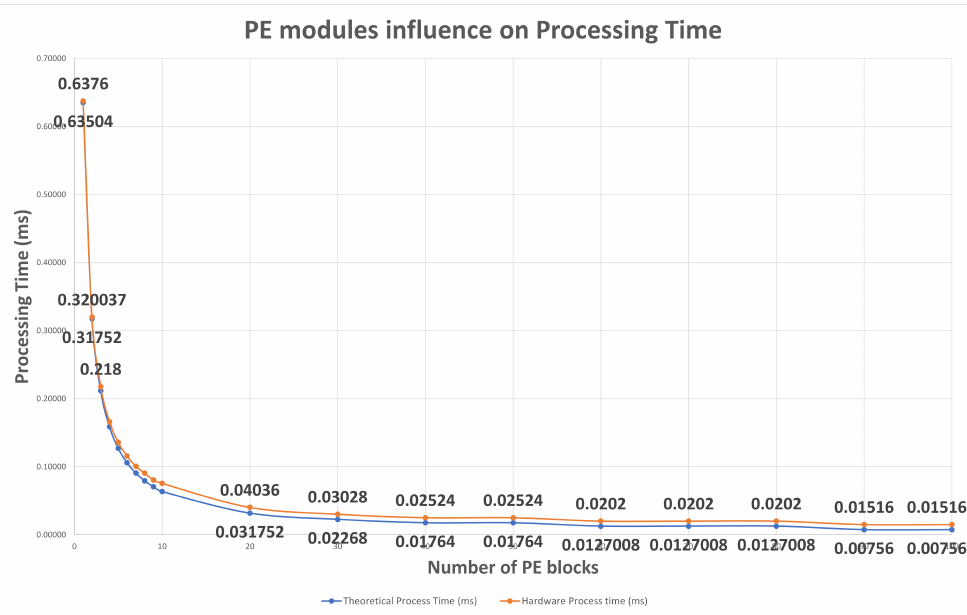
Figure 9. Study of PE modules influence on processing time. It begins with 1 PE block and finishes with 100 PE